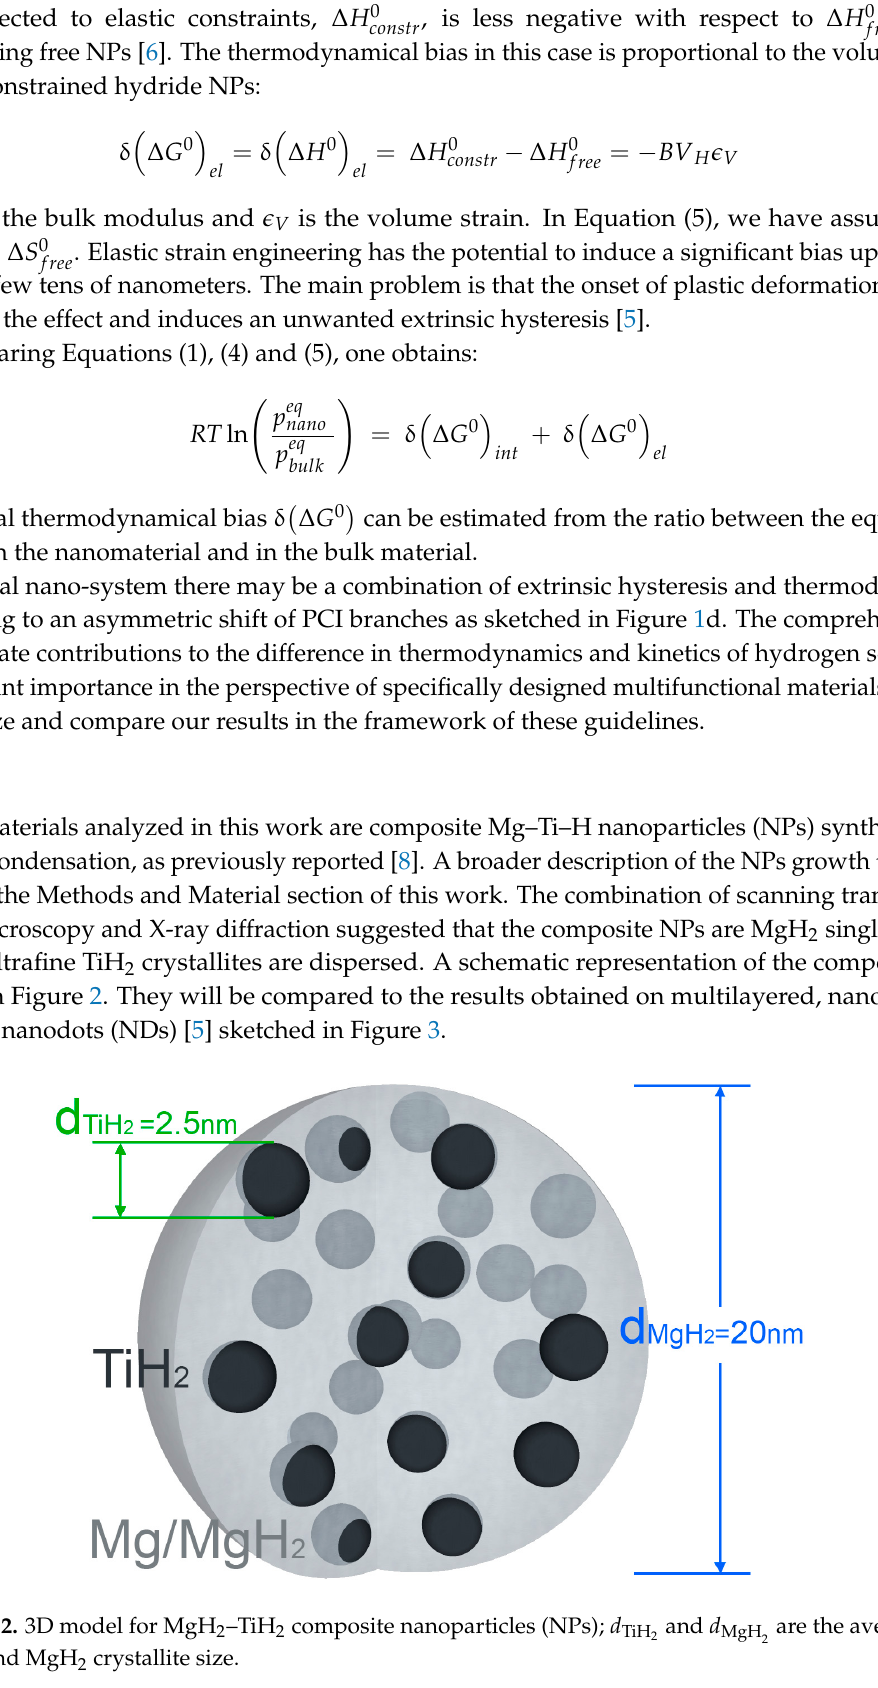
and (cid:1856) (cid:2897)(cid:2917)(cid:2892) are the average and d MgH are the average (cid:3118) (cid:3118) 2 2